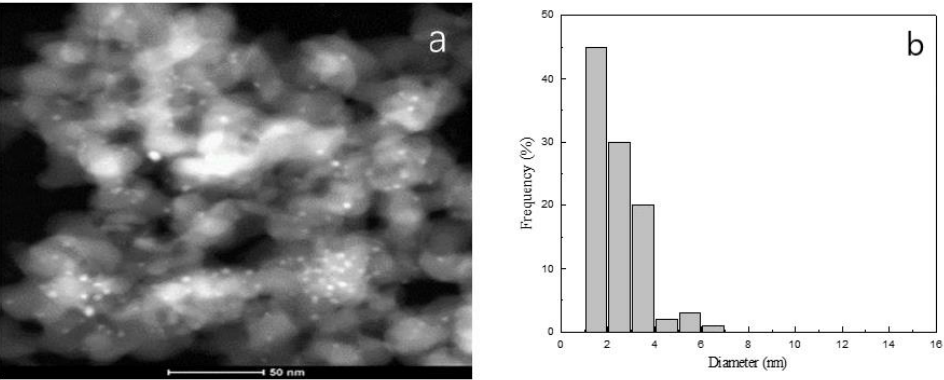
Figure 5. STEM ( a ) and particle size distribution histogram ( b ) of Pd-Ni/ γ Al 2 O 3 -SiO 2 catalyst.